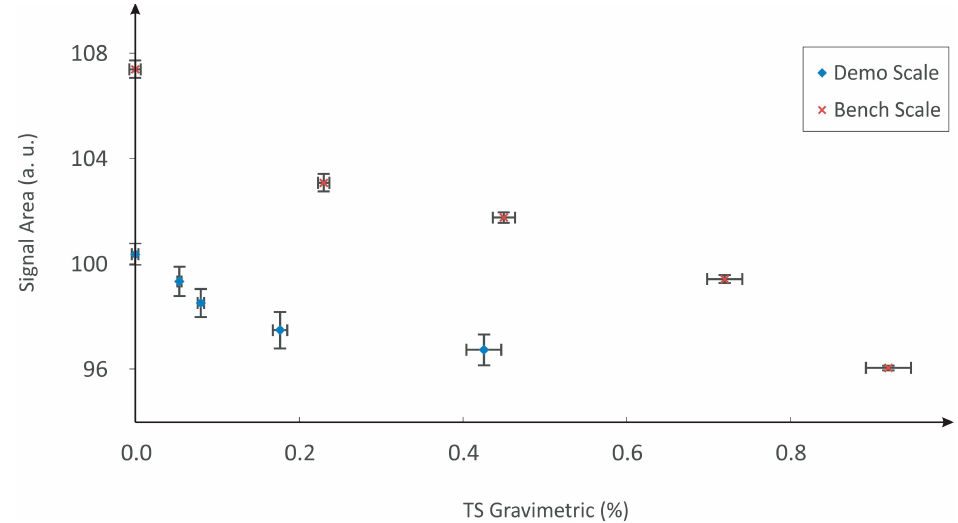
Figure 3. Correlation between the sensor signal and gravimetric analysis obtained during the bench-scale and the demo-scale tests. The error bars are defined as the standard deviation of the sensor signals (vertical error bars) and the standard error calculated from the gravimetric analysis triplicates (horizontal error bars).